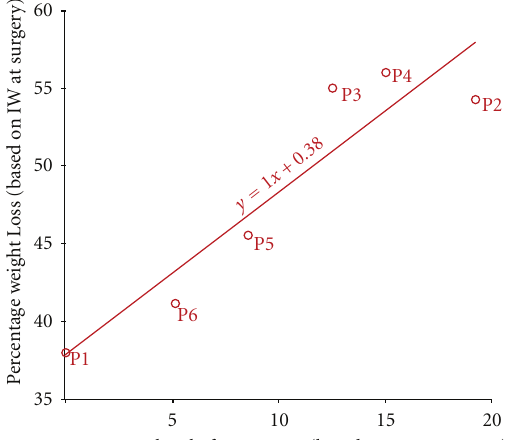
Figure 4: Example of regression. Study includes six hypothetical patients who lost weight preoperatively. The preoperative weight loss is graphed against their complete program weight loss (from initial consultation to one year after